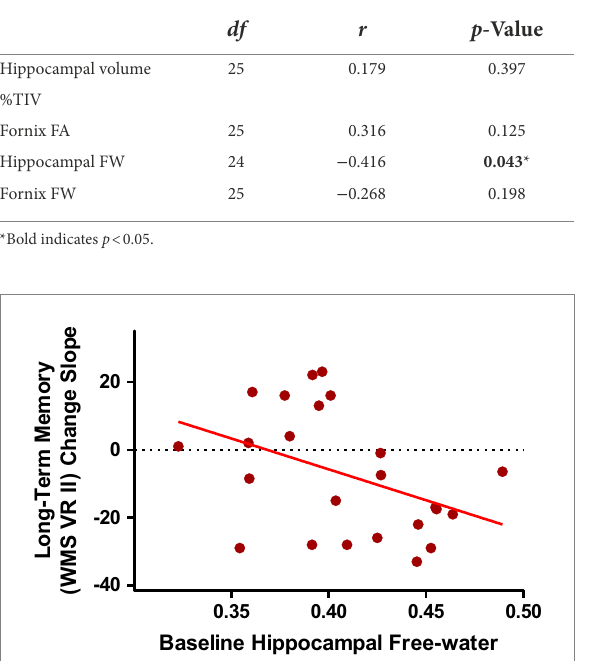
FIGURE 3 Baseline hippocampal free-water correlated with long-term visual memory change slopes in middle-age and older adults with ASD [ r (24) = − 0.416; p =